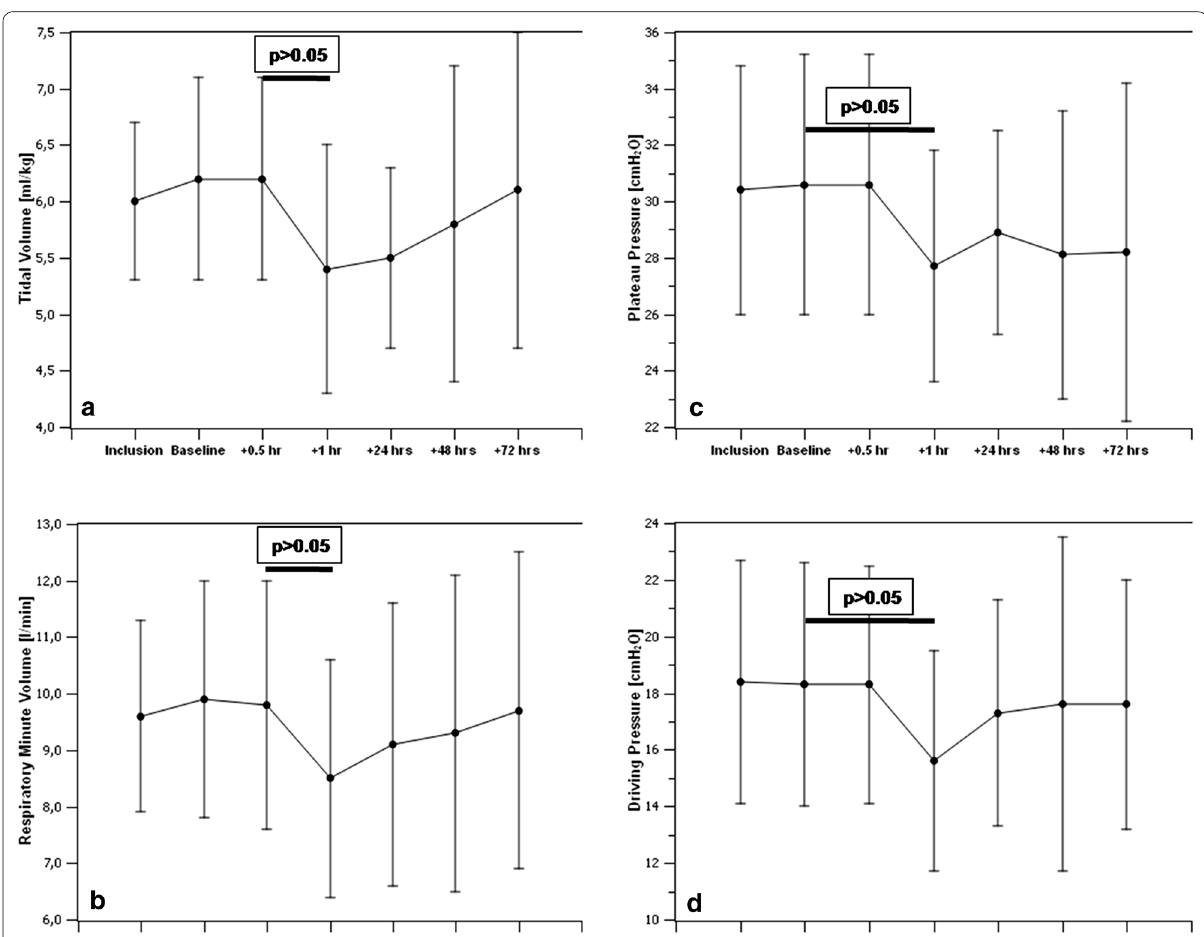
Fig. 3 Changes in ventilation under ECCO 2 R over the study period showing a significant decrease in tidal volumes per predicted body weight ( a ) and respiratory minute ventilation ( b ) compared to baseline, corresponding to a significant decrease in plateau ( c ) and driving pressures ( d